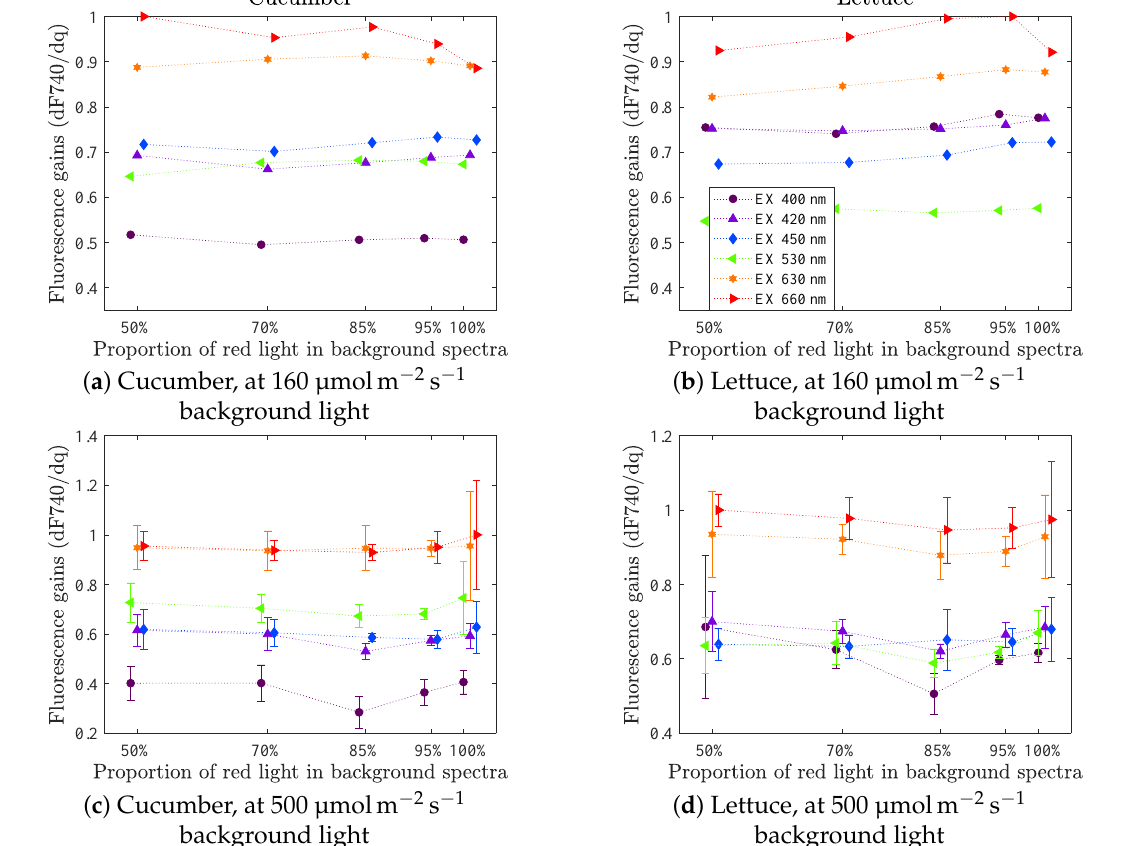
Figure 6. Fluorescence gains for each of the six LED colours when background light quality varies from 50 to 100% red light. The upper row is data from set A, and the lower row is for parts of set B. Left column is measurements on cucumber and right column is on lettuce. The bars in the lower plots represent ± one standard deviation calculated from the measurements at the current light